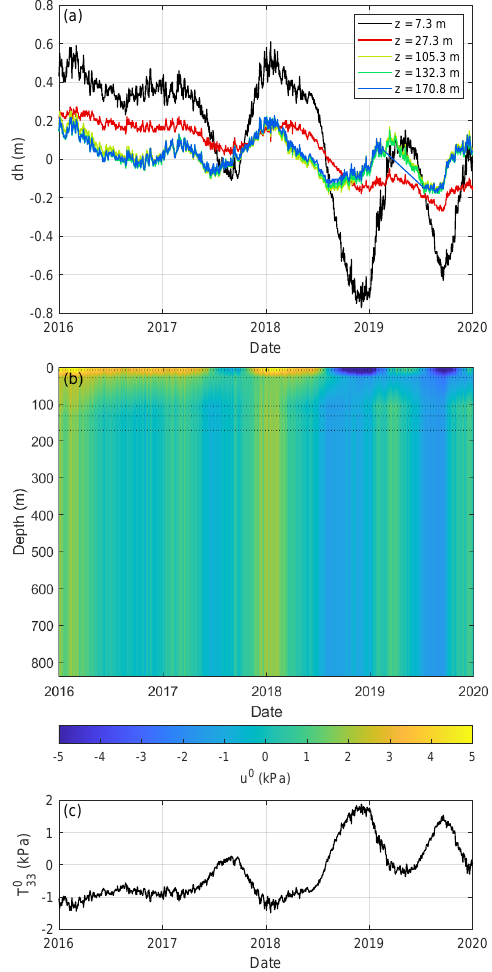
Figure 3. ( a ) Time-lapse changes in pressure head dh ( z i , t ) with respect to the average pressure head between 1 January 2017 and 31 December 2019, for z i = 7.3, 27.3, 105.3, 132.3, and 170.8 m depths. ( b ) Induced pore pressure u 0 ( z , t ) = ρ w g dh ( z , t ) for parameters ρ w = 1000 kg/m 3 and g = 9.8 m/s 2 , obtained from linear interpolation of dh ( z i , t ) . The dashed lines indicate the measurement depths of the pressure head. ( c ) Estimate of induced vertical compressional stress T 0 m, t ) for φ ≈